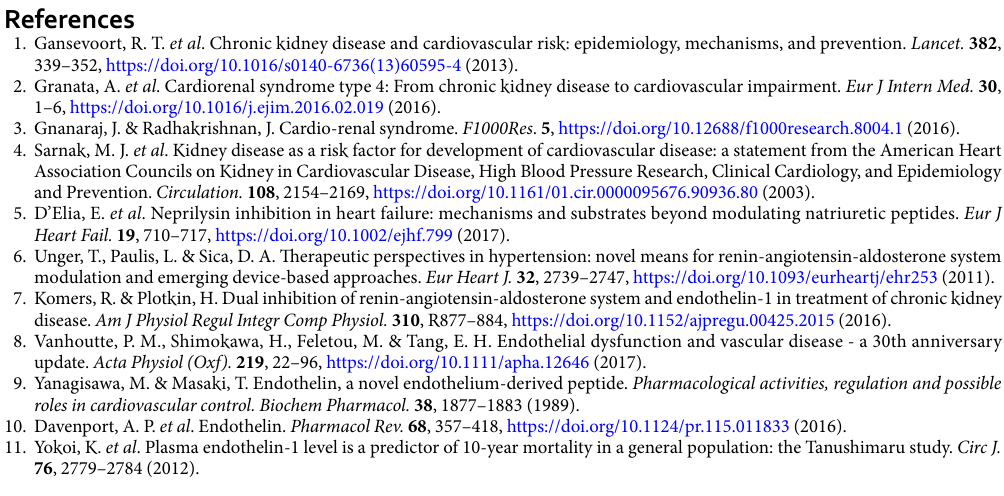
lower eGFR was observed in patients with CAD than in patients without CAD, but the eGFR was not significantly different among patients with CAD presenting with different numbers of narrowed coronary vessels based on